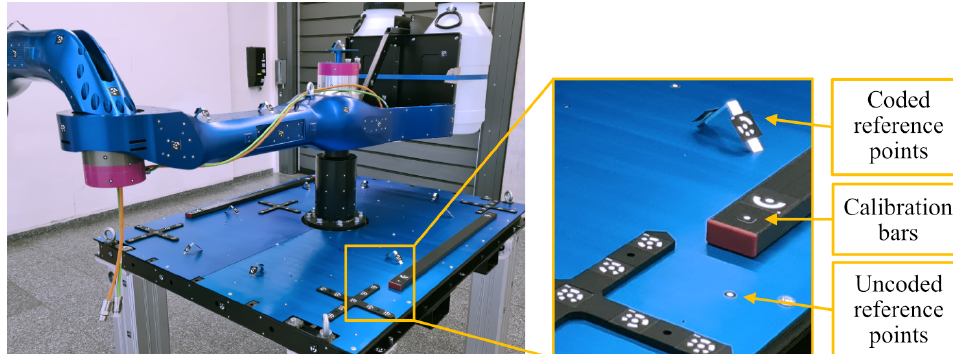
Figure 5. Preparing a scene for photogrammetry.